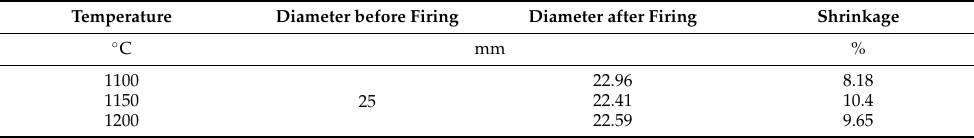
Table 2. Shrinkage of GS samples from 1000 ◦ C to 1200 ◦ C.